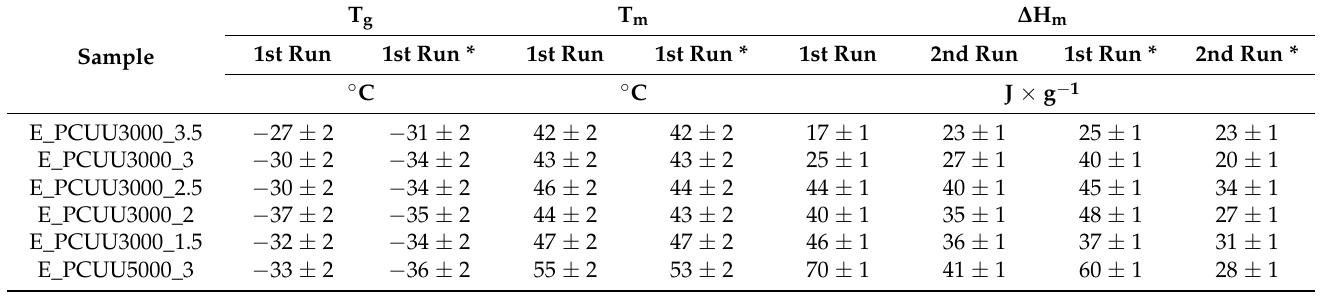
Table 5. T g and melting points based on MDSC for cast PCUU samples and PCUU samples elongated 100%. The * symbol refers to sample elongated with 100% strain (1st run *) and the second heating run of the previously elongated sample after its return to the primary shape (2nd run *).